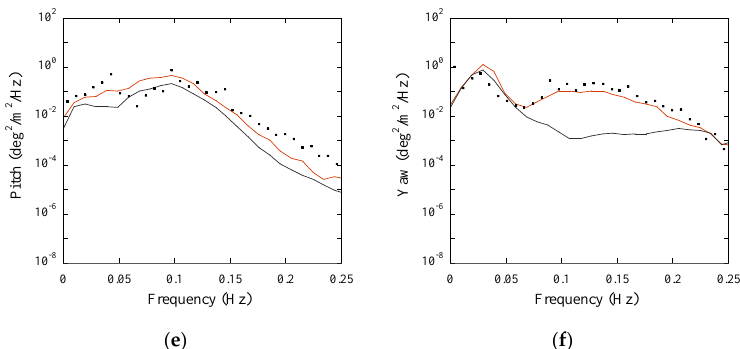
Figure 18. PSD of observed and simulated motions in the six degrees of freedom at the high wave height case. ( a ) PSD of surge, ( b ) PSD of sway motion, ( c ) PSD of heave motion, ( d ) PSD of roll motion, ( e ) PSD of pitch motion and ( f ) PSD of yaw motion.